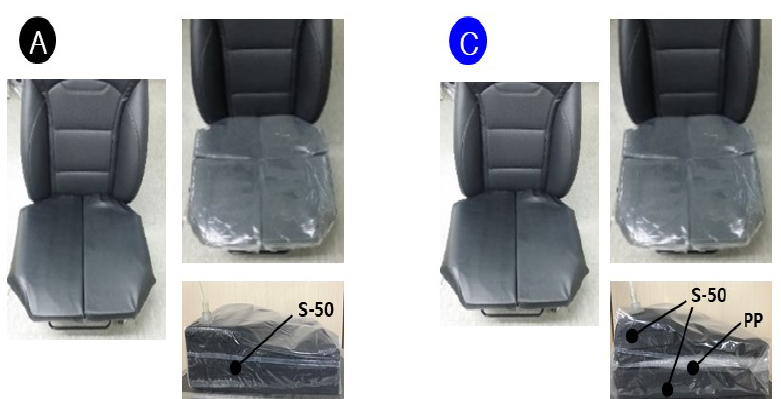
Figure 17. Configuration of pan layer of SSA seats (only for Model A and